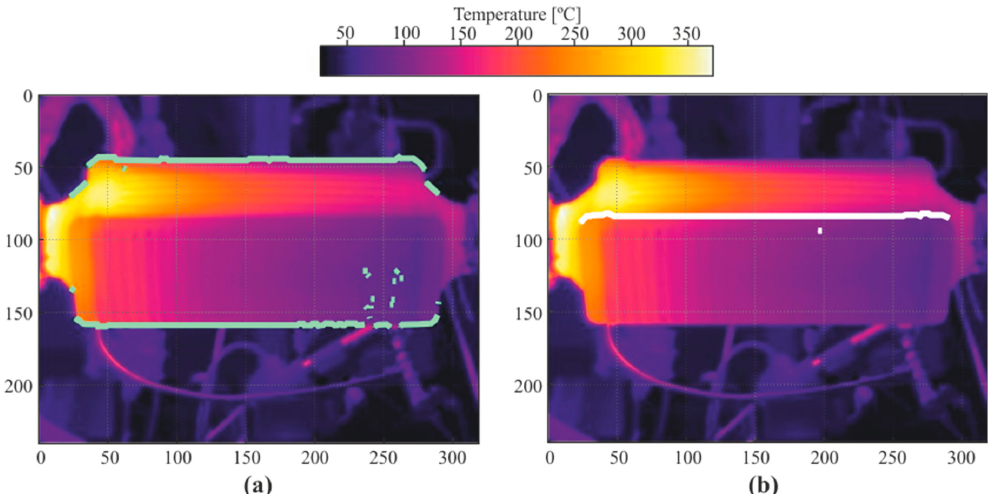
Figure 7. ( a ) The reconstruction of the outermost edges is represented in the color green. ( b ) The reconstruction of the middle edge is represented in the color white. ( b ) The reconstruction of the middle edge is represented in the color